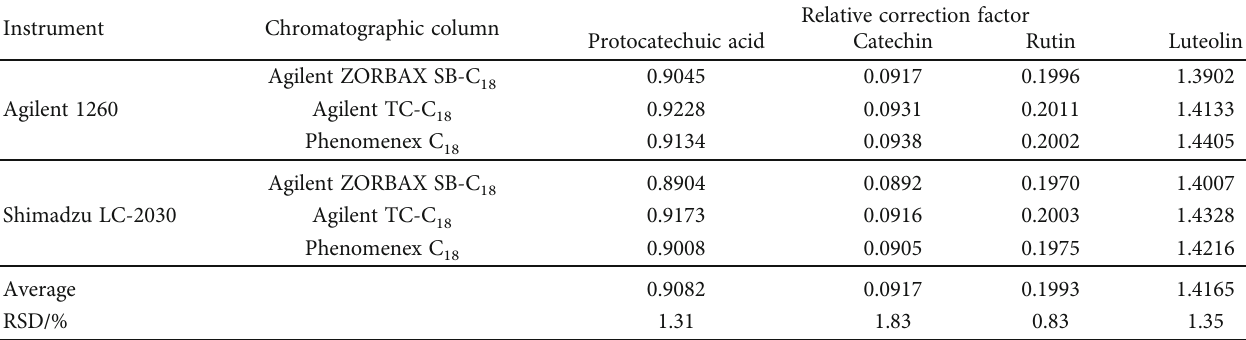
Table 5: E ff ects of di ff erent instruments and columns on relative correction factors.